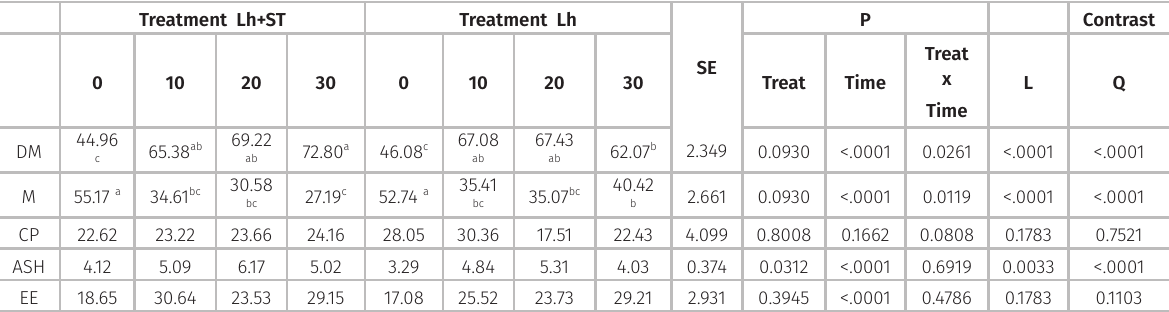
Table III. Bromatological composition of ripened cheeses. Treatment Lh+ST Treatment